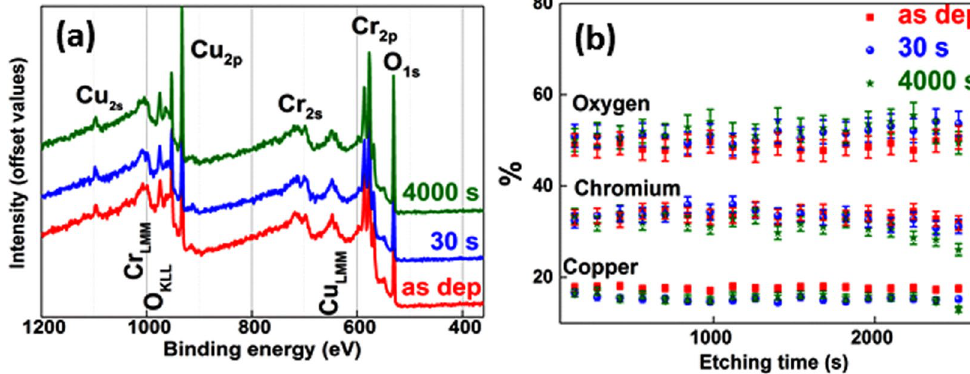
Figure 1. (a) Full XPS spectra for as-deposited and annealed films for 30 and respectively 4000 s; (b) measured chemical composition for same films; Annealing temperature: 900